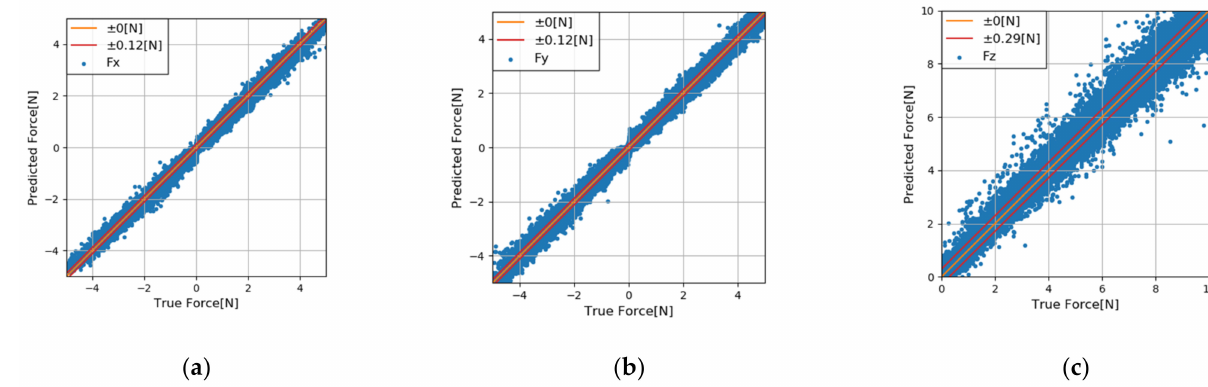
Figure 6. Correlation between estimated and true values: ( a ) F x ; ( b ) F y ; ( c ) F z